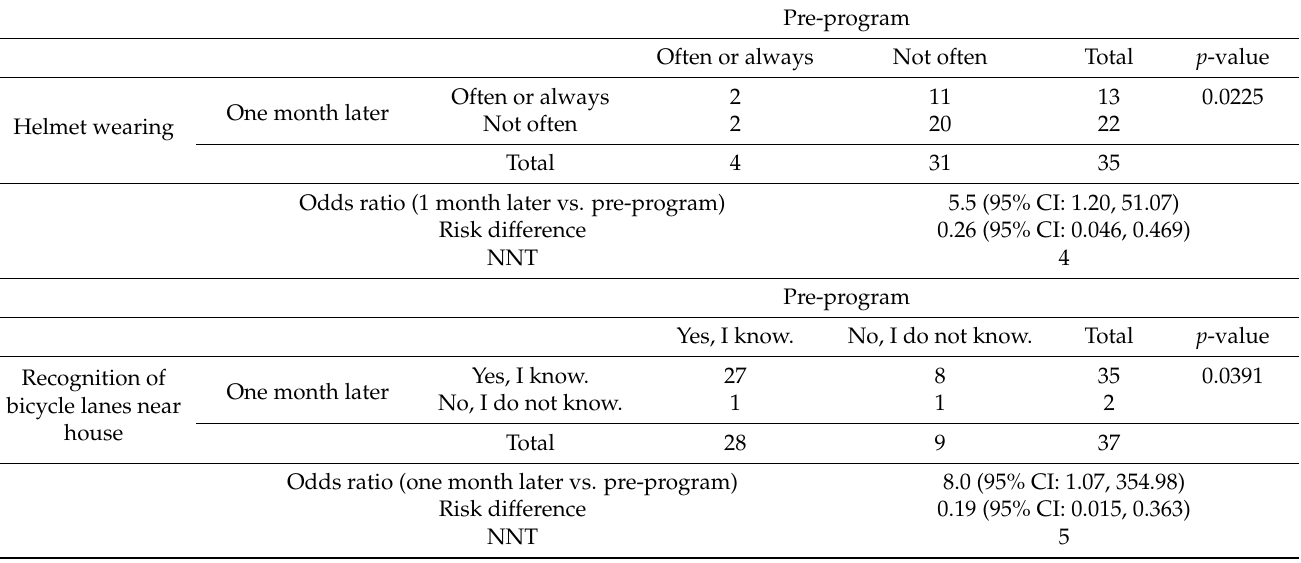
Table 3. Changes in attitudes toward wearing a helmet and environmental